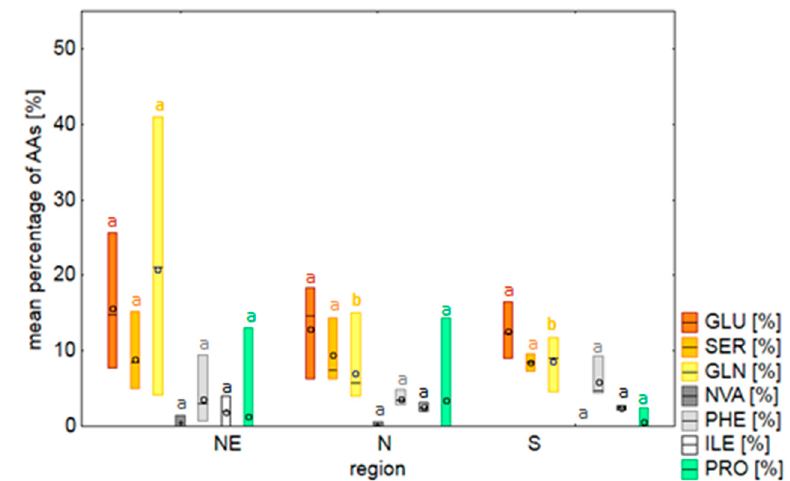
Figure 2. The mean percentage of AAs selected for the linear mixed models and proline (vital AA for pollinators) in populations of Polemonium caeruleum from three regions in Poland. GLN (glutamine), GLU (glutamic acid), SER (serine); ILE (isoleucine), PHE (phenylalanine), NVA (norvaline), and PRO (proline). The sample number for each region was n = 18 for northeastern (NE) populations, n = 7 for northern ( n ) populations, and n = 4 for southern (S) populations. The line in the middle of the box represents the median and the circle represents the mean. Boxes extend from the 5th to 95th percentiles. Means of AAs that varied significantly between regions are marked with different letters ( p < 0.05).